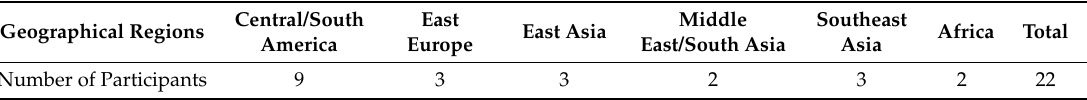
Table 1. Research Participants from non-English-Speaking Countries, by Geographical Regions of Source